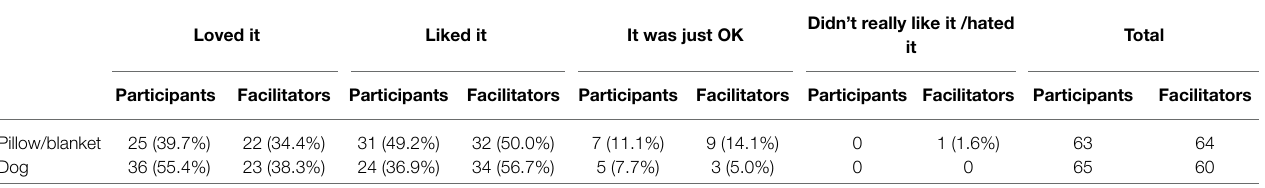
TABLE 1 | Partcipants’ and facilitators’ rating of the virtual body scan intervention for dog and pillow/blanket groups. Loved it Liked it It was just OK